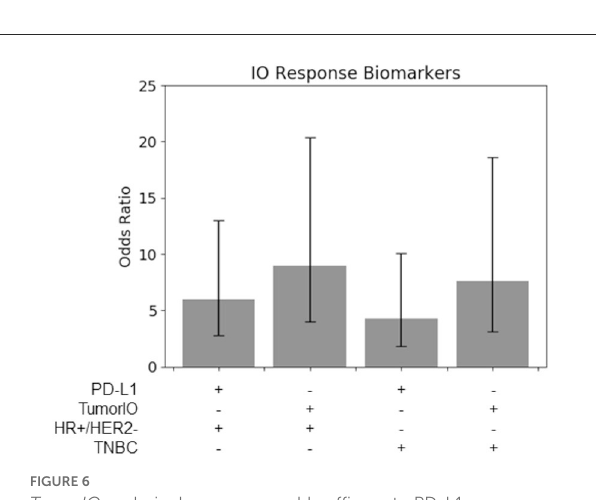
FIGURE6 TumorIO analysis shows comparable efficacy to PD-L1 transcriptomics. Odds ratios of PD-L1 transcriptional levels, in comparison to the TumorIO Score , when predicting pCR in response to ICI therapy.